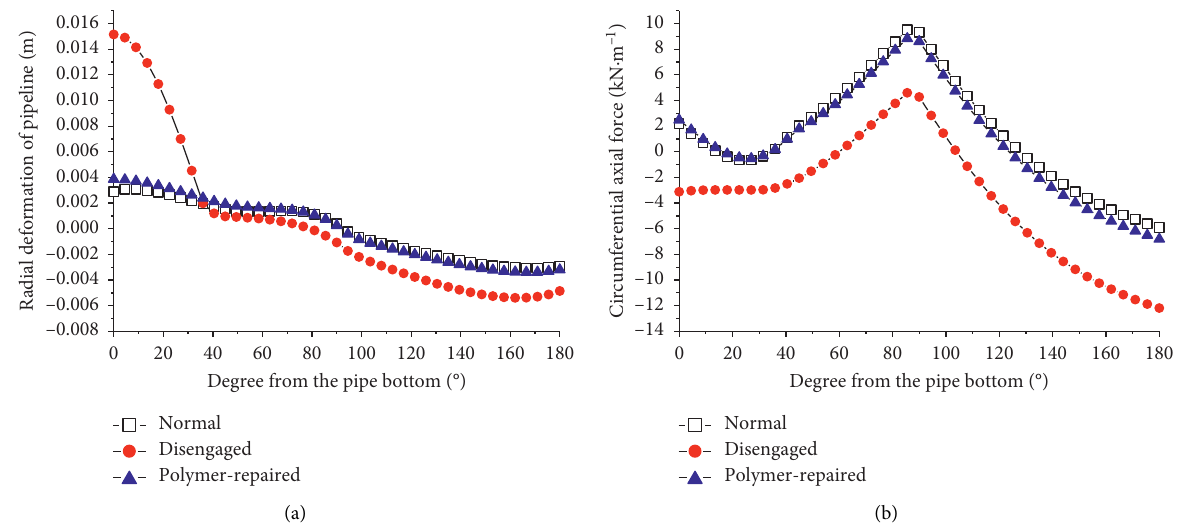
Figure 10: Calculation results of the Vlazov model. (a) Radial deformation. (b) Circumferential axial force.